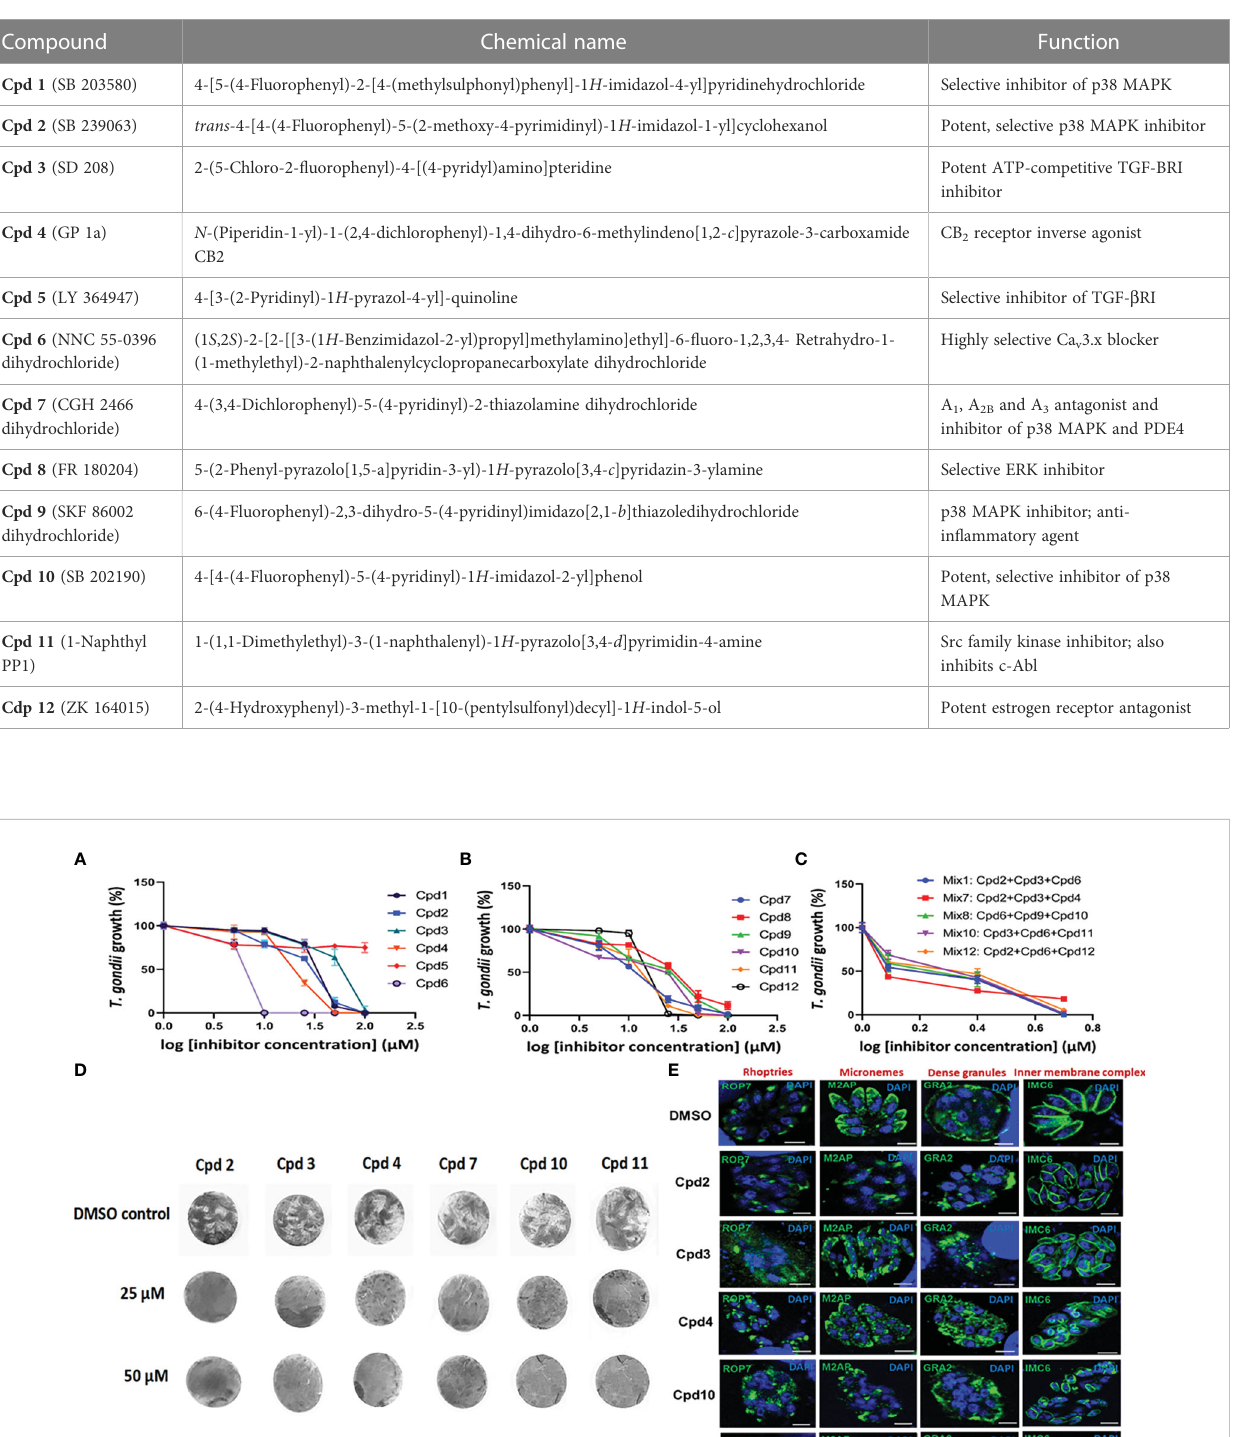
TABLE 2 Chemical names and known functions of compounds identi fi